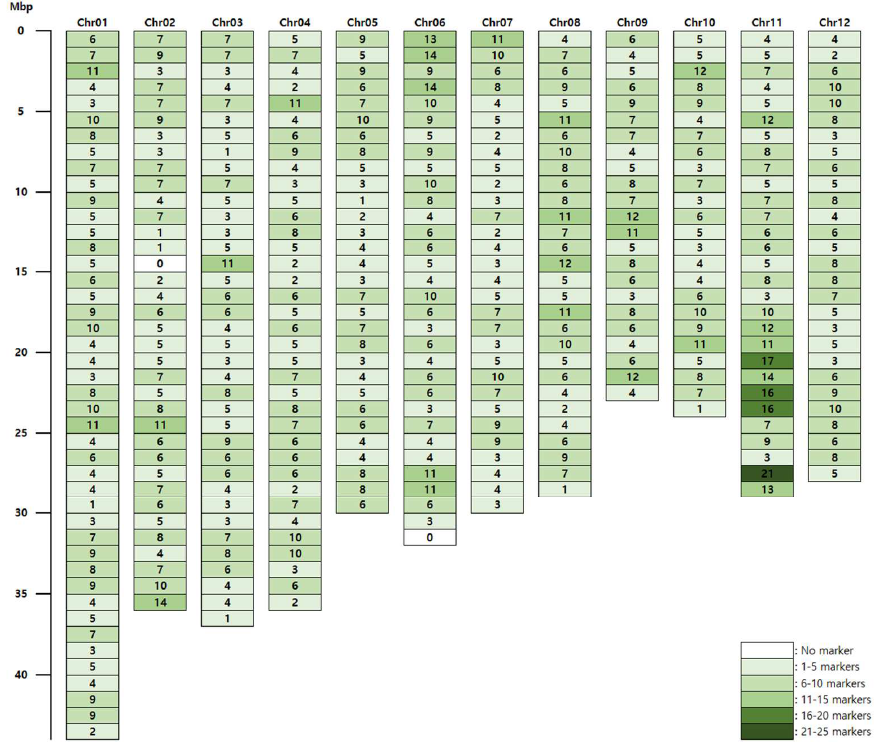
Figure 1. Distribution of SNP markers included in the target capture panel across the rice reference genome. Columns represent chromosomes, and rows represent physical positions (1 Mbp intervals). The numbers of SNP markers per Mbp are shown in each row; cell colors differ according to SNP marker density, as indicated in the legend in the lower right-hand corner of the figure.